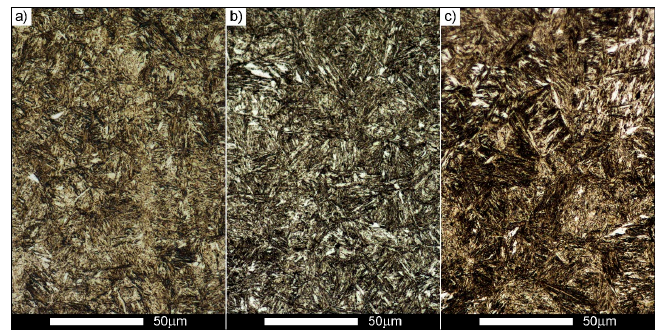
Figure 7. Microstructures of the Hardox 600 joint within the base material ca. 20 mm from the weld axis—BM in Figure 3: ( a ) before welding; ( b ) after welding; and ( c ) after welding and heat treatment. Light microscopy, etched with 2% HNO 3 .